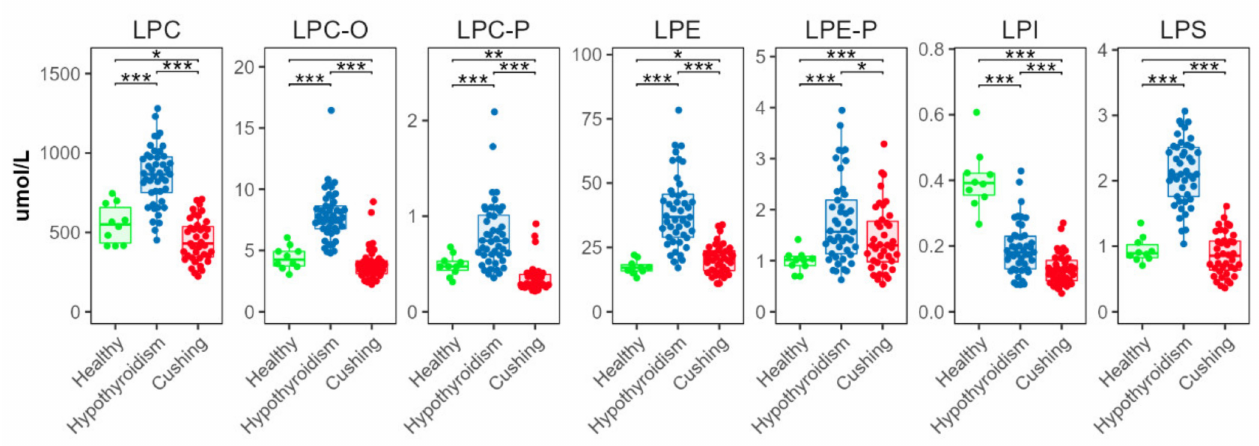
Figure 5. Total abundances of species from lysophospholipid classes. Levels of statistical significance between two groups calculated by two-tailed Welch’s t -tests are indicated with stars: * p ≤ 0.05, ** p ≤ 0.01, *** p ≤